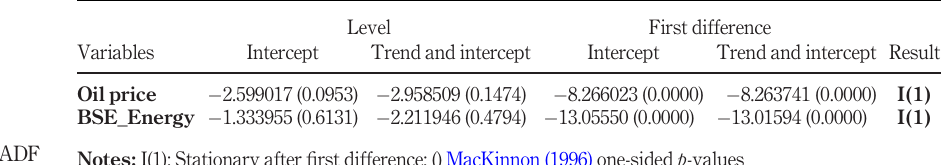
Table 2. Results of the ADF unit root